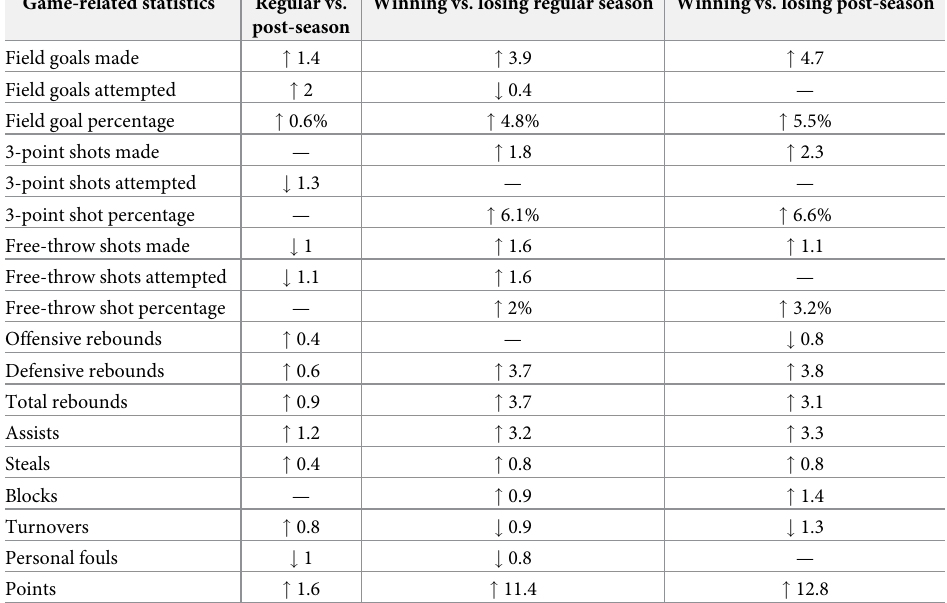
Table 4. Summary of differences in game-related performance parameters between (a) regular and post-season competitive periods, (b) winning and losing game outcomes during the regular season competitive period, and (c) winning and losing outcomes during the post-season competitive period. Upward arrow ( " ) represents a significant increase, arrow down ( # ) represents a significant decrease, and dash (—) represents no statistically significant